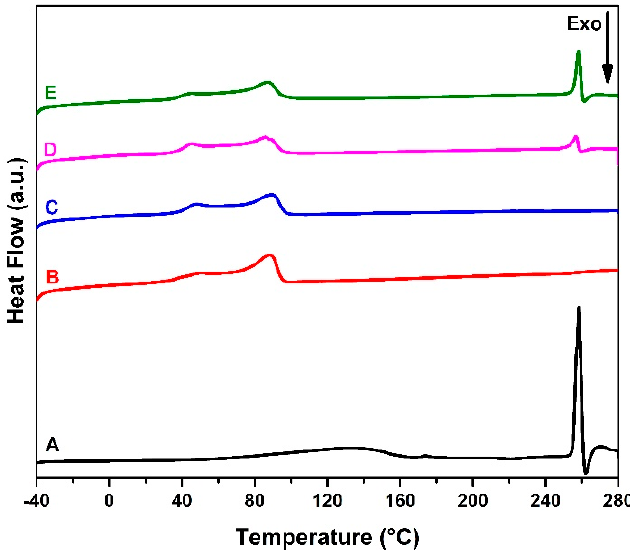
Figure 4. DSC thermograms of ACV (A), EVA pellet (B) and 3D-printed samples EVA-P (C), EVA-P10 (D), and EVA-P20 (E).